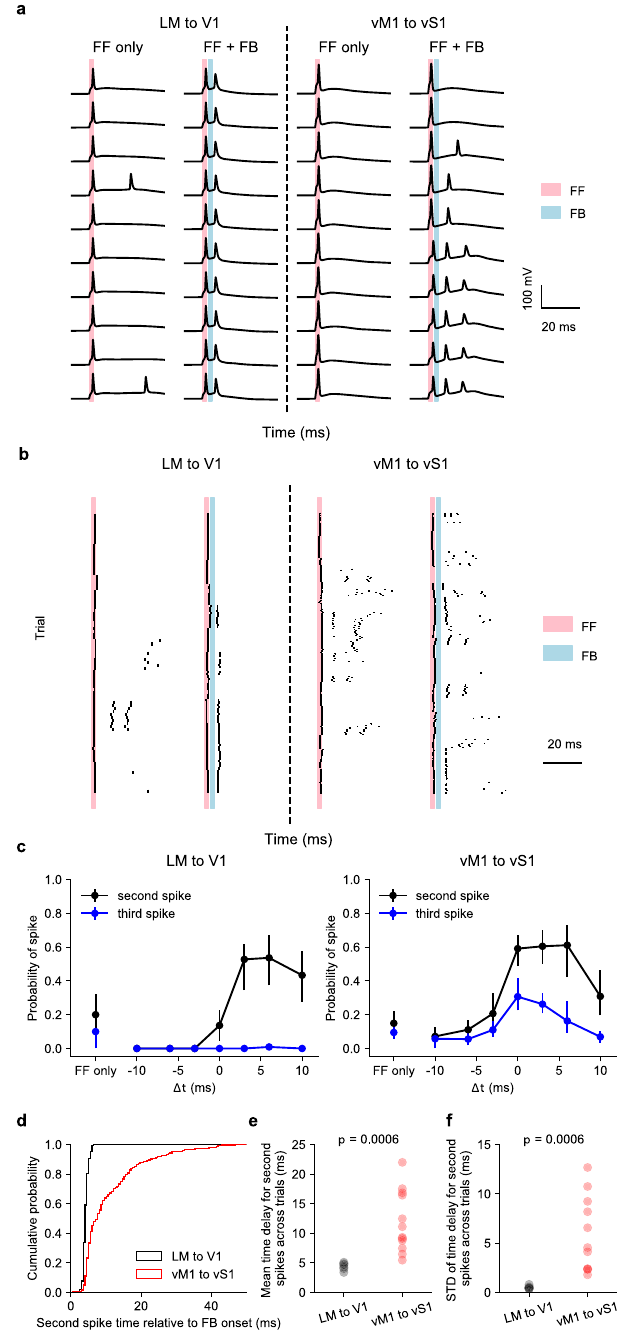
Fig. 5|Feedbackregulationonbursting behavior ofL5intrinsicallybursty(IB) neurons. a Firing of example L5 IB neurons in response to feed-forward stimulus only (FF, 2ms) and the combination of feed-forward and feedback stimulus (FF+ FB, FB 2ms) in V1 (left) or vS1 (right). In these examples, the FB stimulus was delivered 3ms after the FF stimulus. b Raster plots of all cells in V1 (left) or vS1 (right). Each row refers to a trial and each tick indicates a spike. c Probability of occurrence of the second spike (black) and third spike (blue) of L5 IB neurons responsive to FF+FB stimulus, as a function of the time of FB onset relative to the FF onset ( Δ t ). Dots and error bars are mean and bootstrapped 68% con fi dence intervals of the mean. n =11 cells over 2 independent experiments for LM to V1 feedback; n =15 cells over 5 independent experiments for vM1 to vS1 feedback. d Cumulative probability of second spike occurrencetime relative to the FBonset. Black:LMtoV1.Red:vM1tovS1. e , f Mean( e )andstandarddeviation(STD, f )ofthe time delay across trials for the second spikes were both signi fi cantly higher in the vM1 to vS1 pathway ( n =6 cells over 2 independent experiments for LM to V1 feedback; n =11 cells over 5 independent experiments for vM1 to vS1 feedback; p =0.0006, two-sided Wilcoxon rank-sum test). Each dot represents a cell. Source data are provided as a Source Data fi